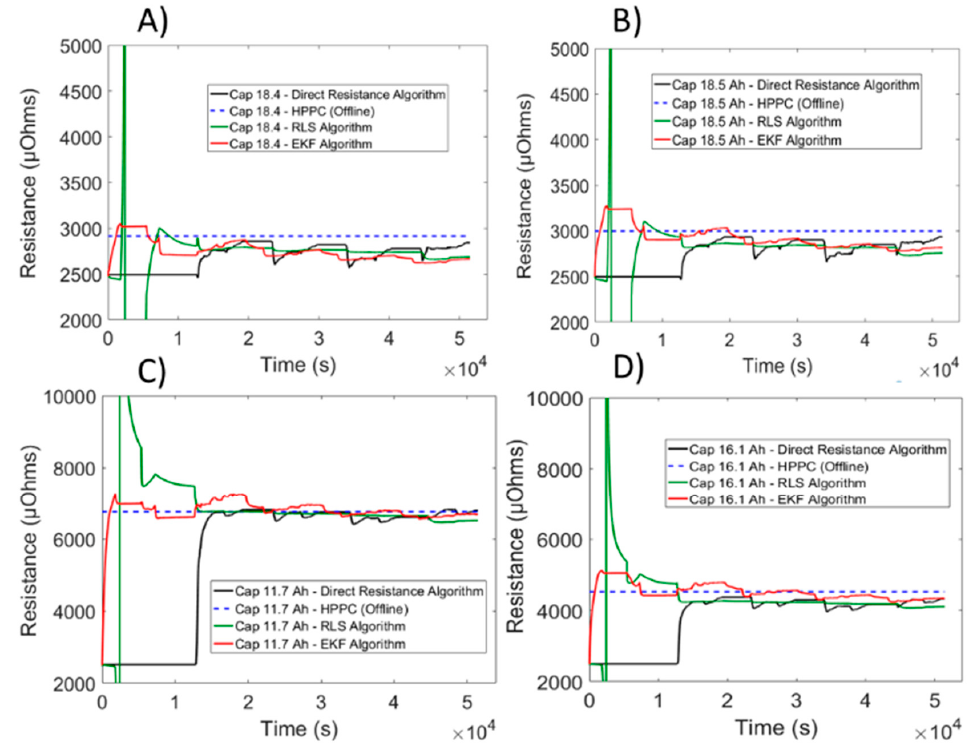
Figure 6. Resistance estimations from the HPPC test, EKF algorithm, RLS algorithm and DRE algorithm for cell one ( A ), two ( C ), three ( B ) and four ( D ) at a constant temperature of 20 °C.